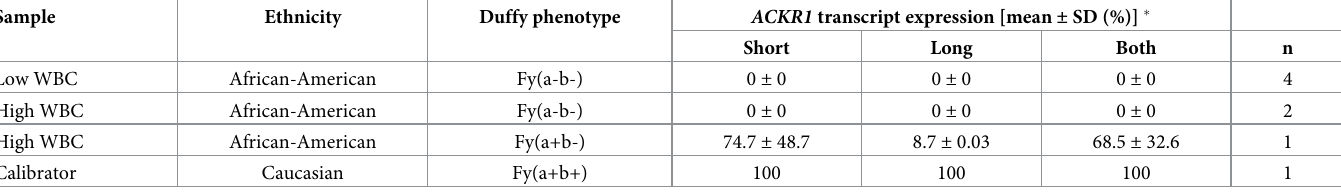
Table 4. Relative expression of DARC (ACKR1) gene